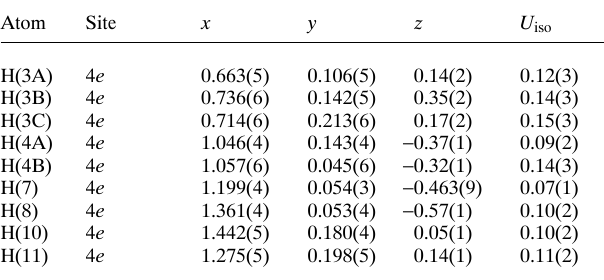
Table 2. A tomic coordin a tes a nd displ a cement p a r a meters (in Å 2 ) .